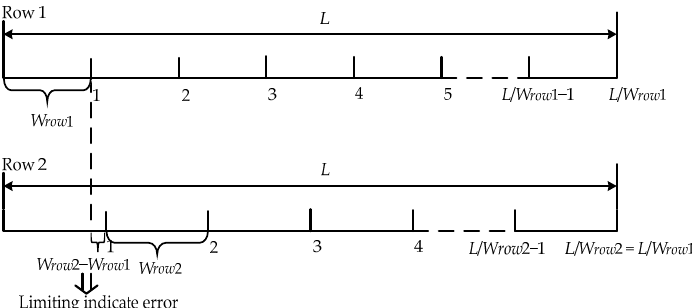
Figure 4. Schematic illustrating the determination of the limit of error for the proposed VATG sensor.